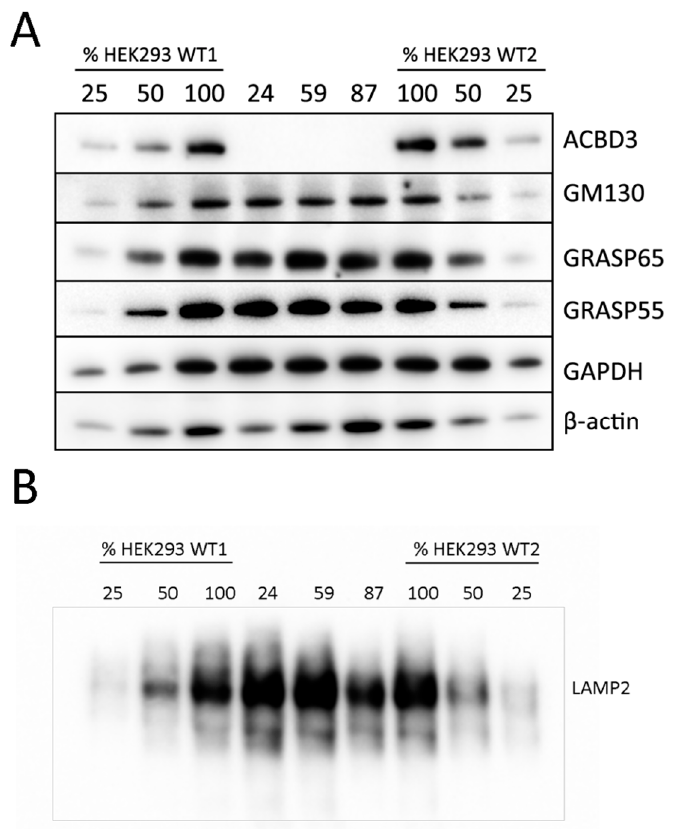
Figure A2. ( A ) Western blots of selected Golgi proteins in HEK293 ACBD3-KO cells. ( B ) Glycosylation of LAMP2 glycoprotein in HEK293 ACBD3-KO cells.